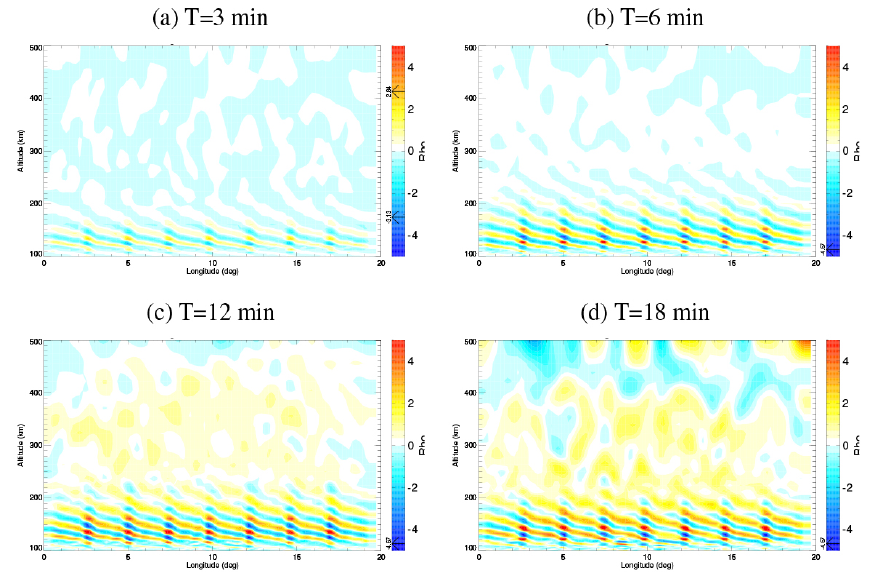
Fig. 2. Altitude–longitude distribution of neutral density percentage difference at equator 3min (a) , 6min (b) , 12min (c) and 18min (d) af- ter adding in the high-frequency wave ( ω = 0 . 75 ω B , λ = 4 πH ) oscillation to the zonal wind at the lower boundary. ω B is the buoyancy frequency, and H is the scale height at the lower boundary.